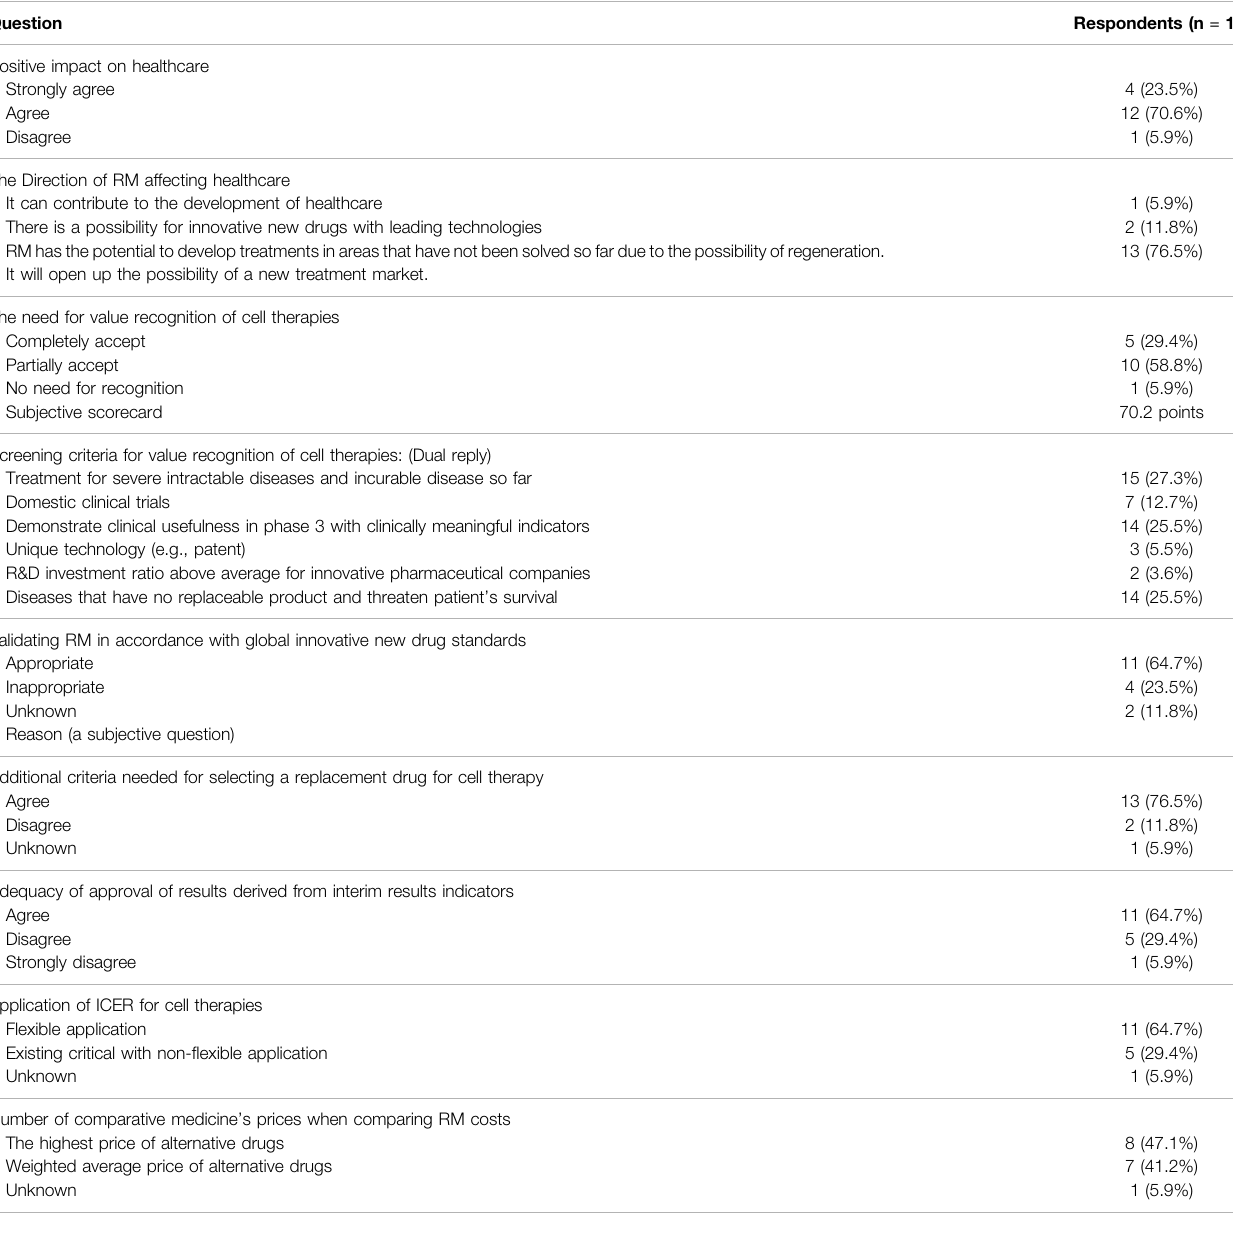
TABLE 2 | Recognition of RM ’ s value and how to decide pricing of